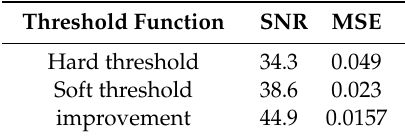
Table 2. X-axis values of the parameters Allan